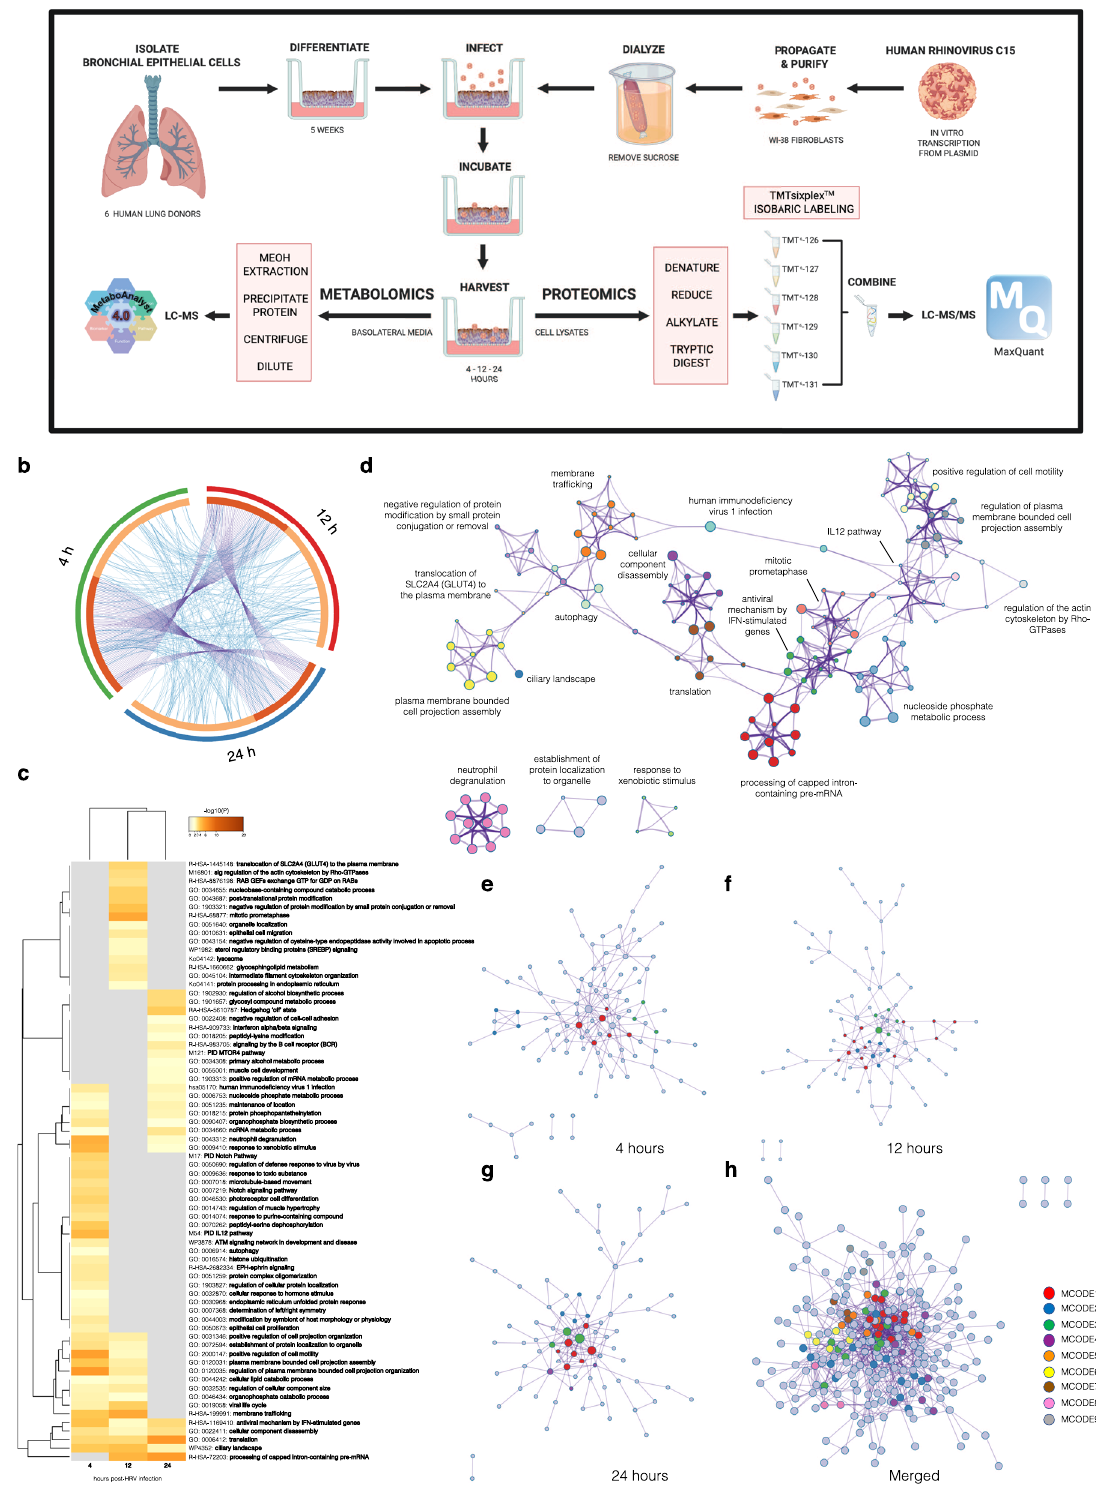
pantetheine prosthetic group. The phospho-pantetheine moiety is donated to these proteins by CoA and is used to shuttle inter- mediates between the active sites of enzymes involved in fatty acid, non-ribosomal peptide, and polyketide synthesis. CoA is an essential cofactor for cell growth and is involved in many meta- bolic reactions, including the synthesis of phospholipids, synthesis and degradation of fatty acids, and the TCA cycle.